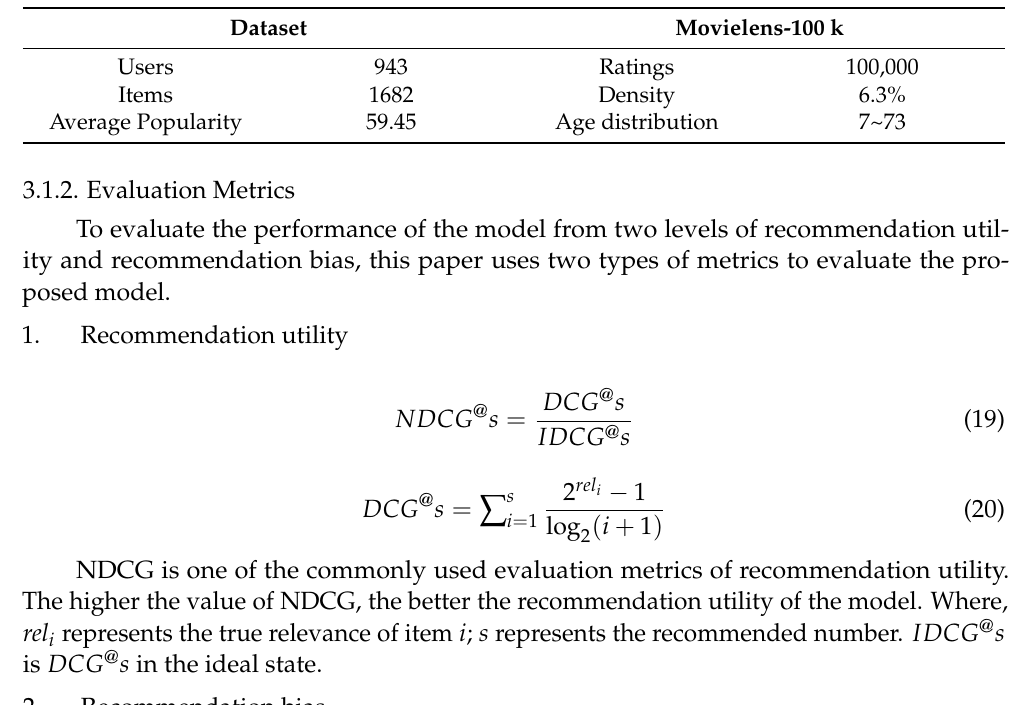
Table 1. Information of Movielens